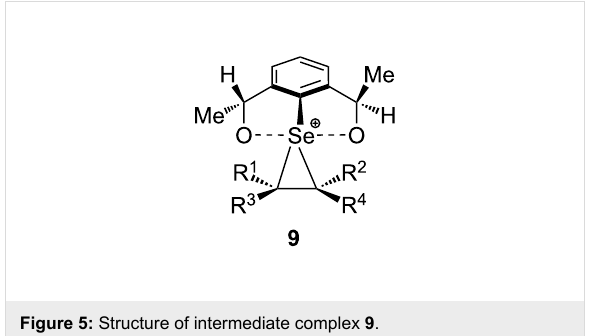
Figure 5: Structure of intermediate complex 9 .